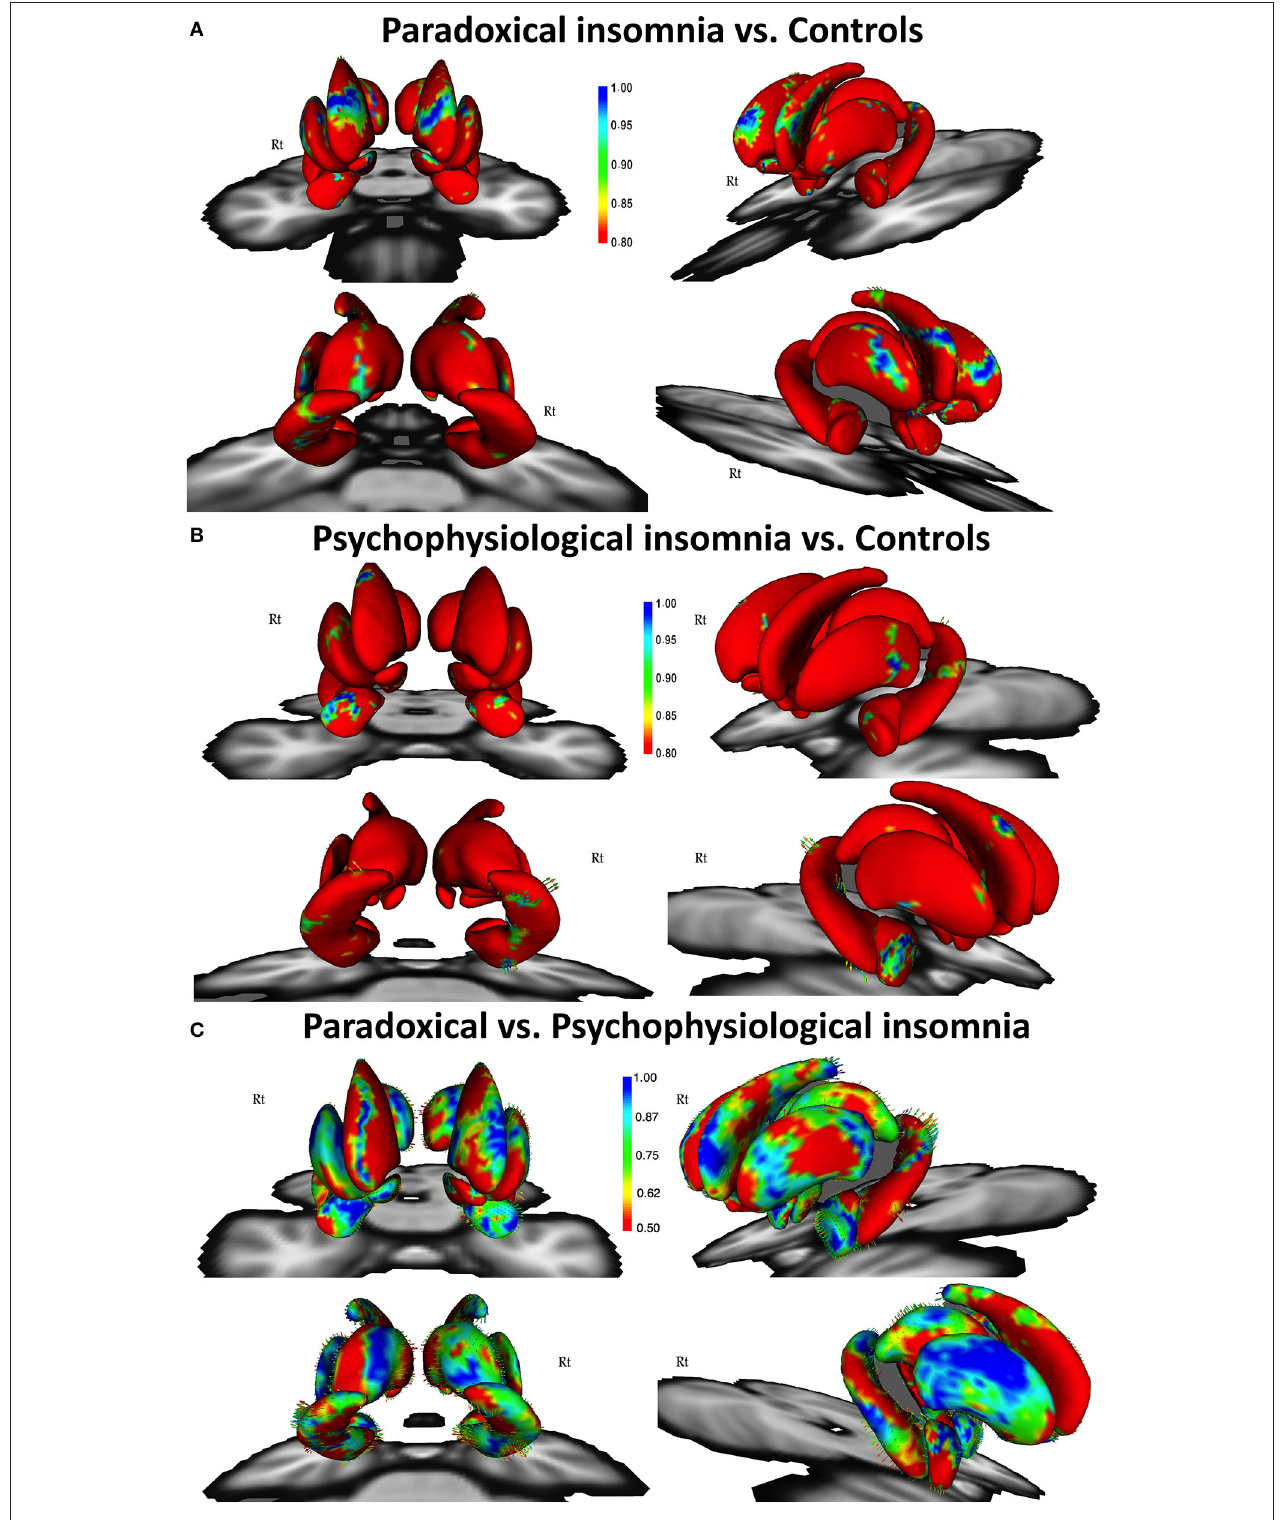
FIGURE 1 | Vertex-wise surface analysis comparing patients with paradoxical insomnia vs. control group (A) , patients with psychophysiological insomnia vs. control group (B) , patients with paradoxical insomnia vs. psychophysiological insomnia (C) including covariates of no-interest (i.e., age, gender, and total brain volume). Color bar shows false discovery rate (FDR) corrected p